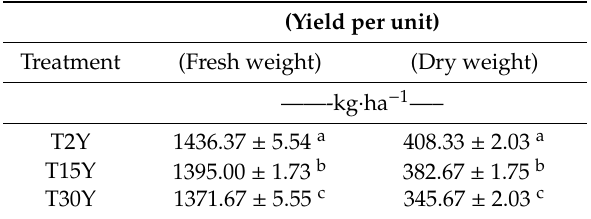
Table 1. Yield of Tea Leaves in Di ff erent Age Monoculture Tea Fields.